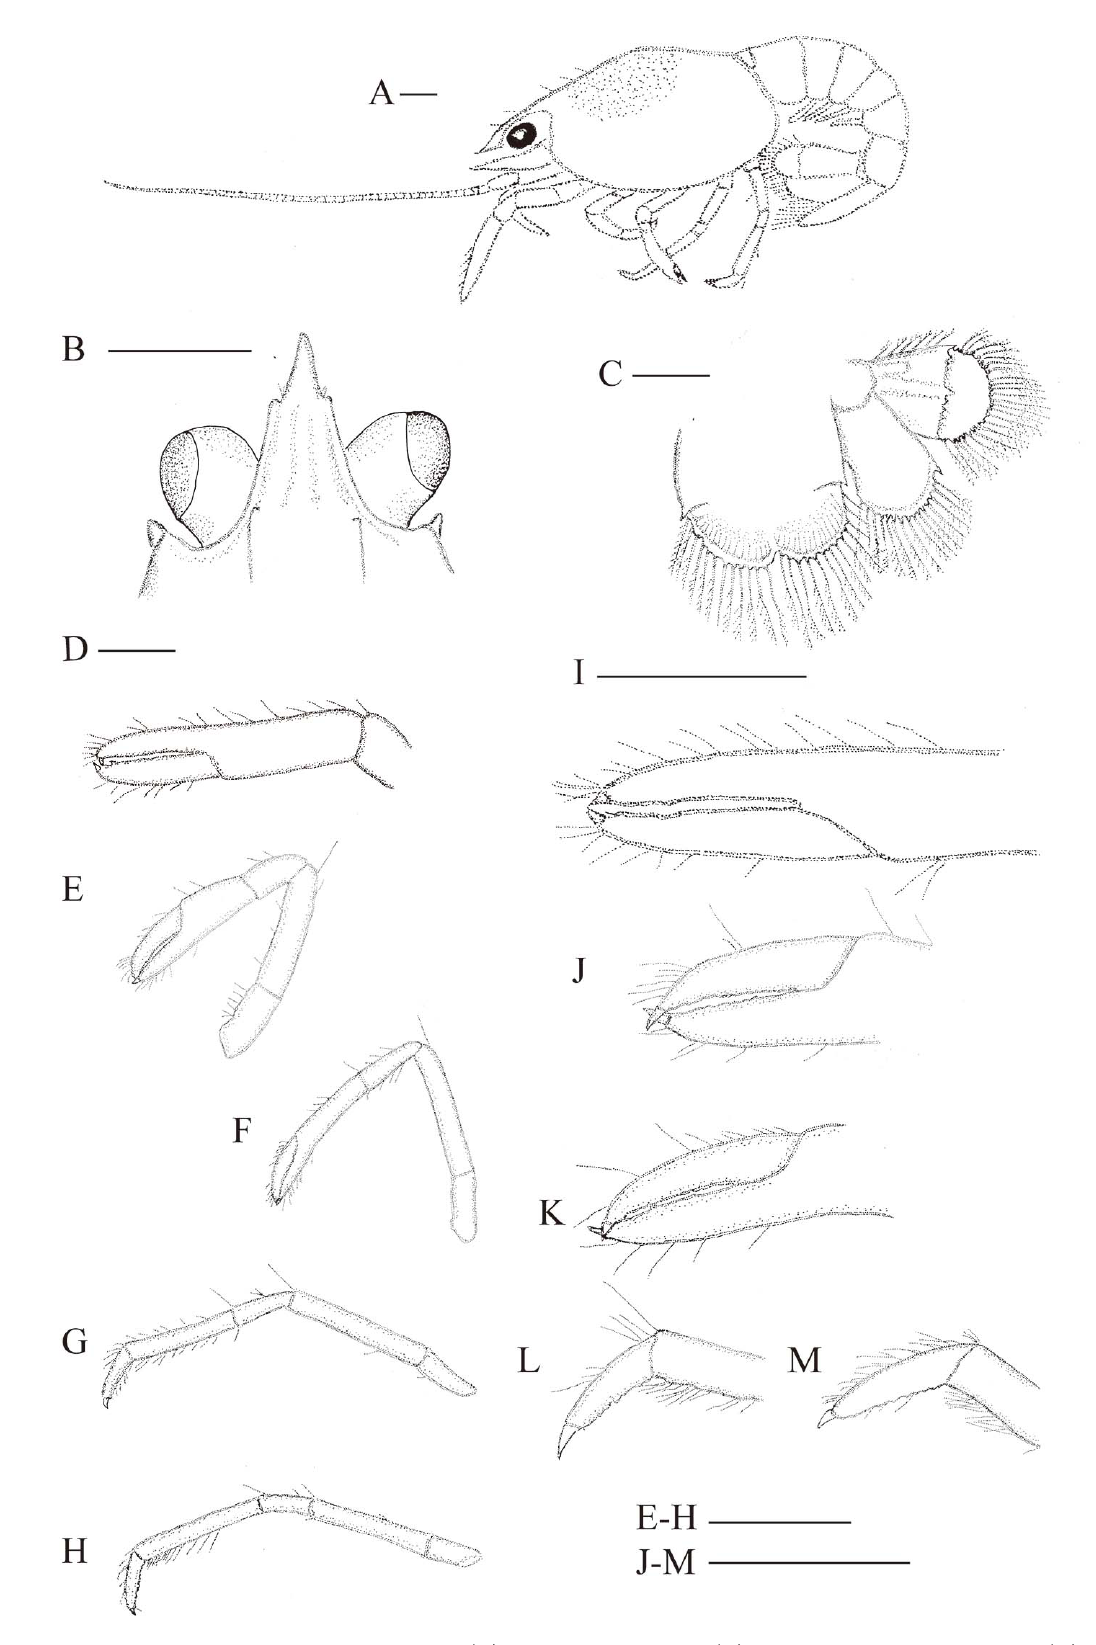
Figure 11. Juvenile Stage III of Procambarus virginalis . ( A ) Habitus, lateral view; ( B ) eyes and rostrum, dorsal view; ( C ) tail fan, dorsal view; ( D–H ) pereiopods 1–5, dorsal or lateral view; ( I–M ) distal segments of pereiopods 1–5, dorsal or lateral view. Scale bars: 0.25